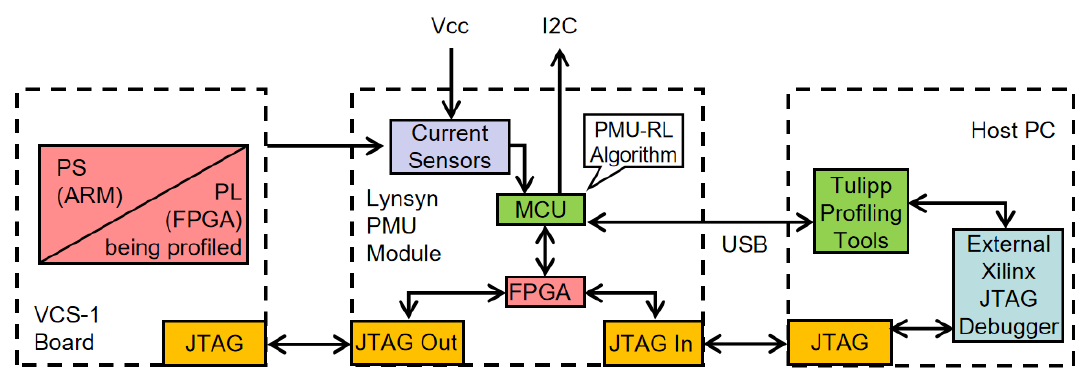
Figure 1. System architecture for field programmable gate array (FPGA) control by power management utility (PMU) module.